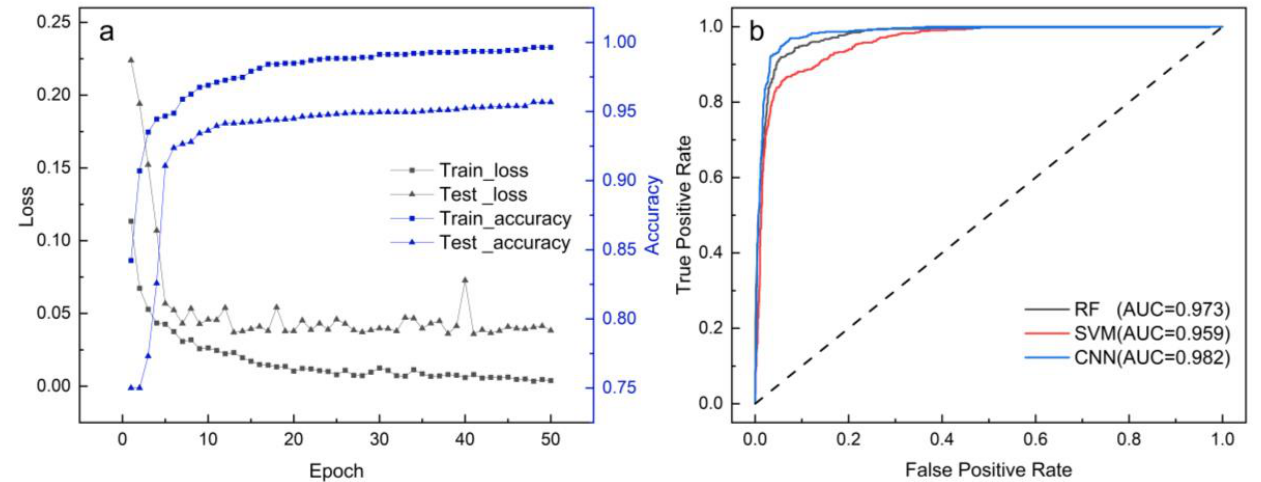
Figure 15. The performances of the three models: ( a ) CNN model, the accuracy and loss of CNN as the epoch grows; ( b ) The ROC curves and AUCs (lower right corner) of 3 models.